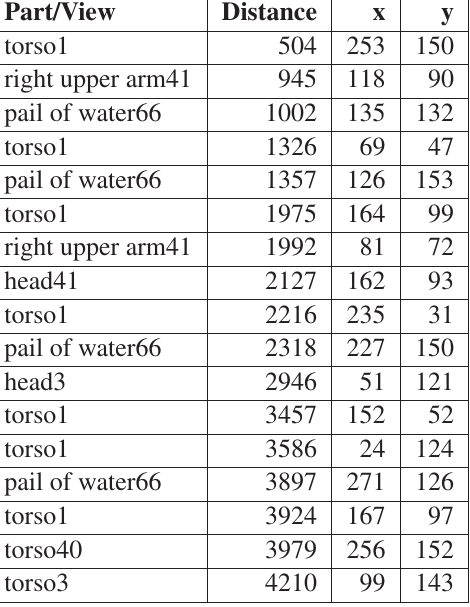
Table 1. Example of nearest neighbor object recognition